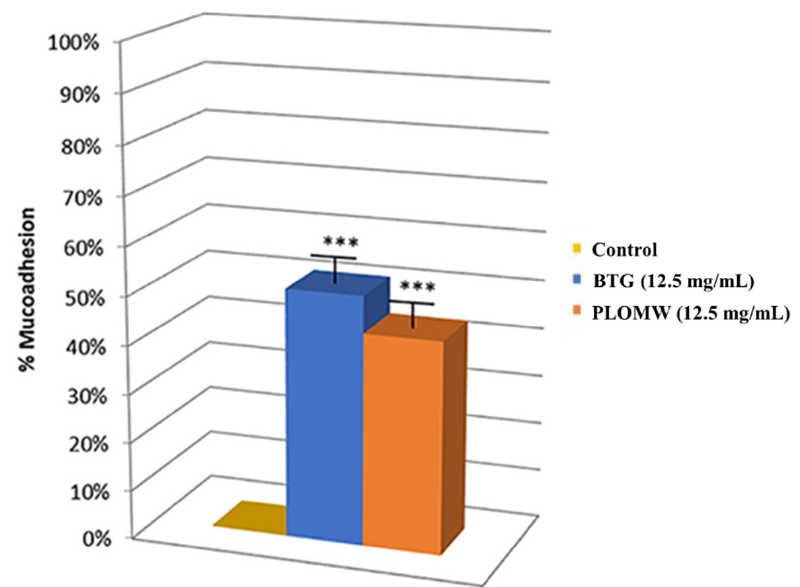
Figure 6. Muco-adhesion of BTG and PLOMW determined as reduction (%) of lectin binding on Caco-2 cells at different concentrations; *** p < 0.001 vs. control.